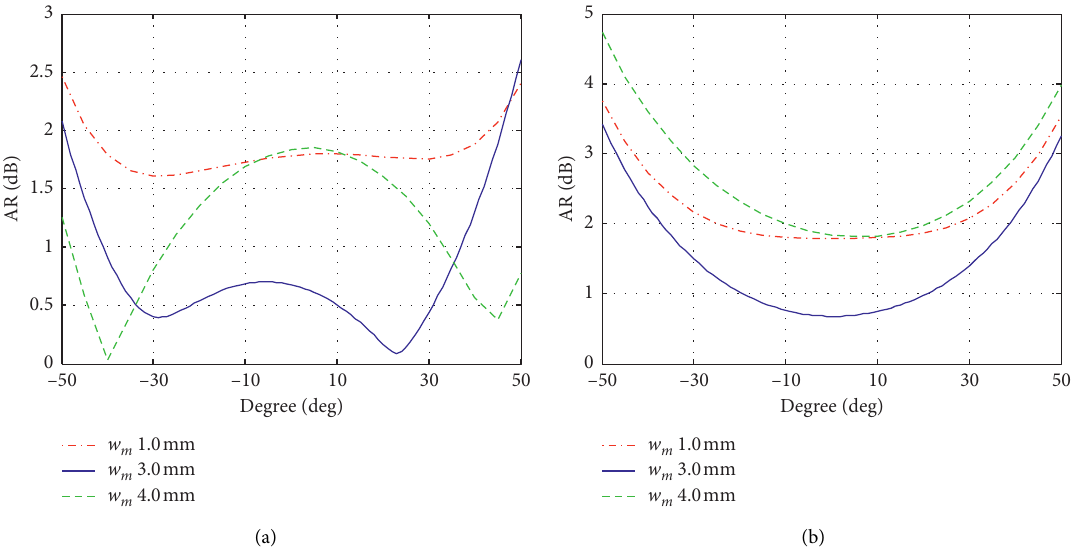
Figure 11: The simulated AR with different w